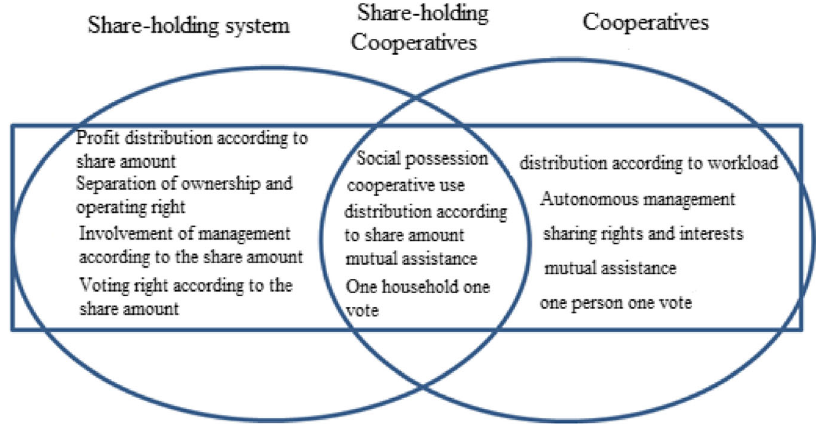
Fig. 1 Distinction of share-holding cooperatives with share-holding systems and cooperatives. Source: made by